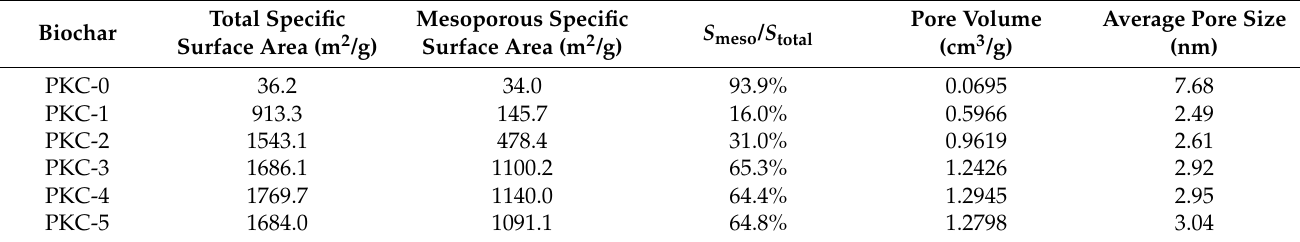
Table 1. Specific surface areas and porosity characteristics of